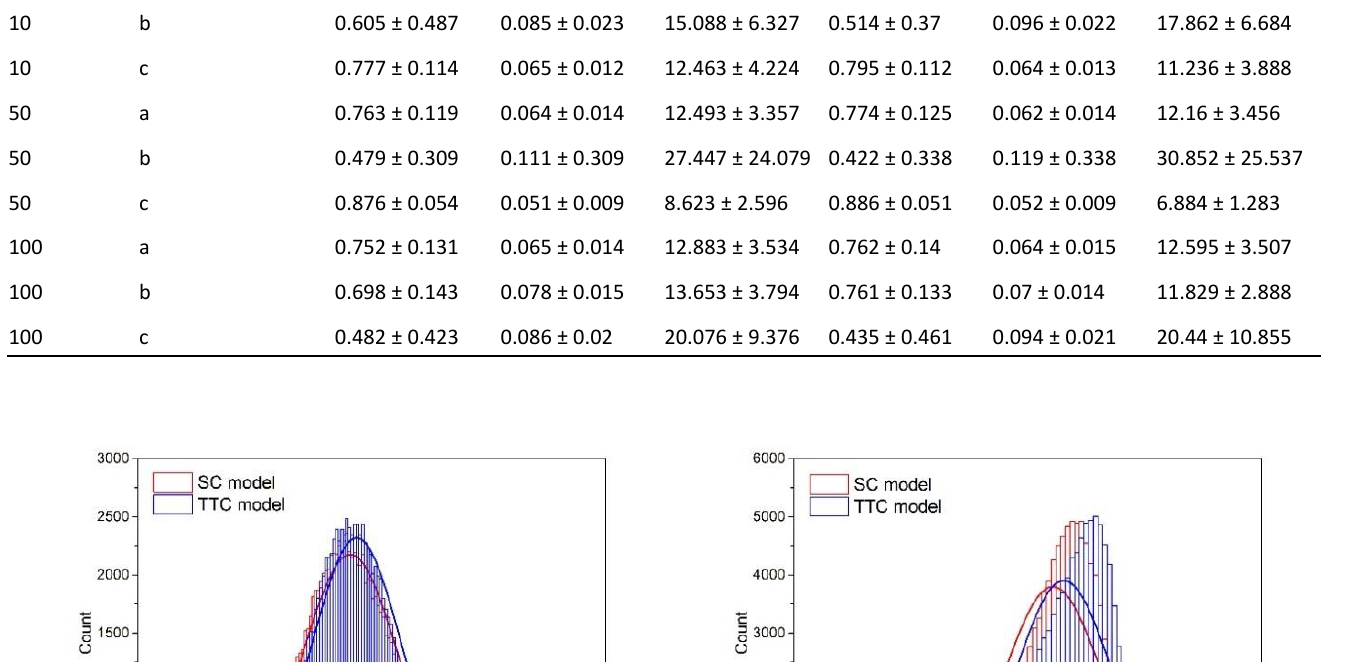
Table 2: Linear regression metrics for FFM estimation: two models (SC and TTC) and nine experimental conditions Frequency, Right hand kHz